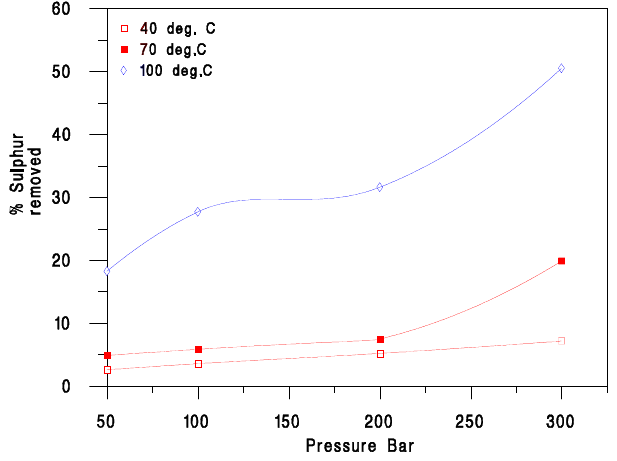
Figure 4. Effect of air pressure on pyritic sulphur removal for Harworth